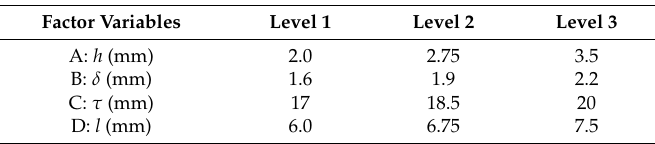
Table 2. Levels of the main factor variables.